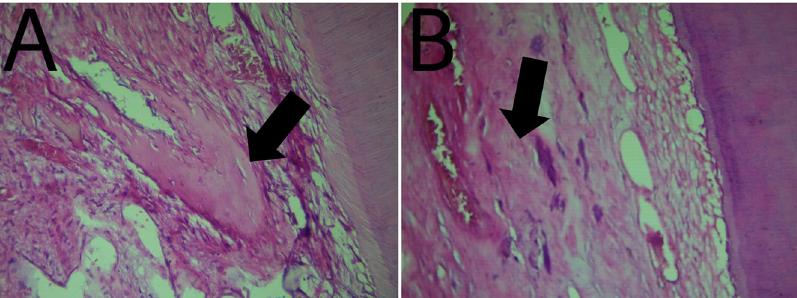
Fig. 5 The arrow points to pulp calci fi cations. A Photomicrograph of dental pulp capped with Portland Cement. B Photomicrograph of dental pulp capped with MTA.